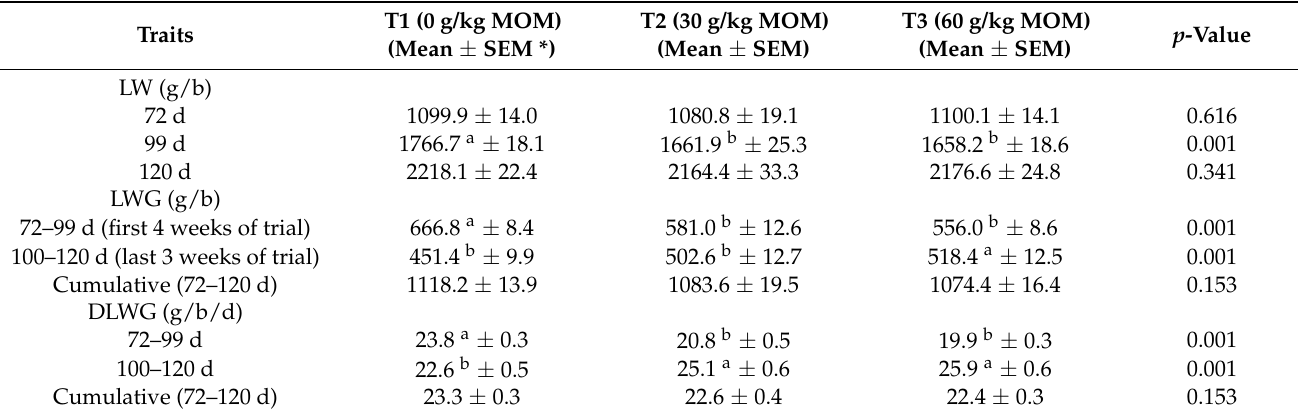
Table 3. Live weight (LW), live weight gain (LWG), and daily live weight gain (DLWG) of slow- growing Dominant CZ Blue D 107 male chickens raised with Moringa oleifera meal (MOM) dietary inclusion in a tropical environment.